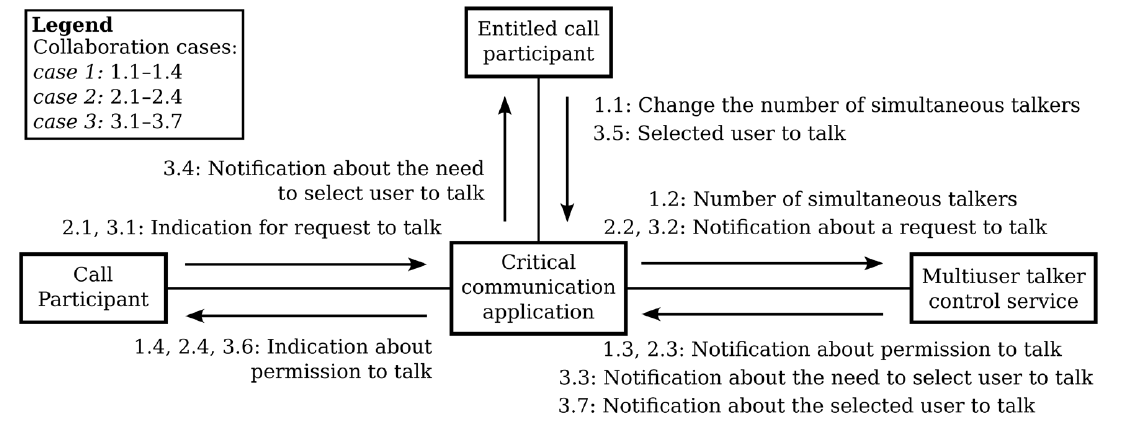
Figure 9. UML communication diagram illustrating the communications in three use cases. Use case 1: Change in the number of simultaneous talkers (the number of simultaneous talkers is higher than the allowed number). Use case 2: The MUTC service is aware of the (initial) permissions to talk and